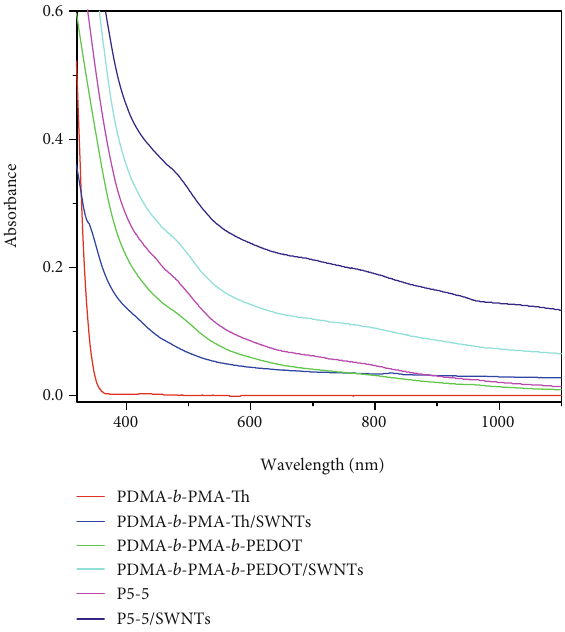
Figure 3: Absorption pro fi les for the modi fi er solution and supernatant of SWNT dispersion. The supernatant was obtained by merging the centrifugal supernatant and the washing liquid (the total volume of washing liquid was four times as much as the volume of dispersion), and all copolymer solutions were diluted to 1/5 of their original concentration